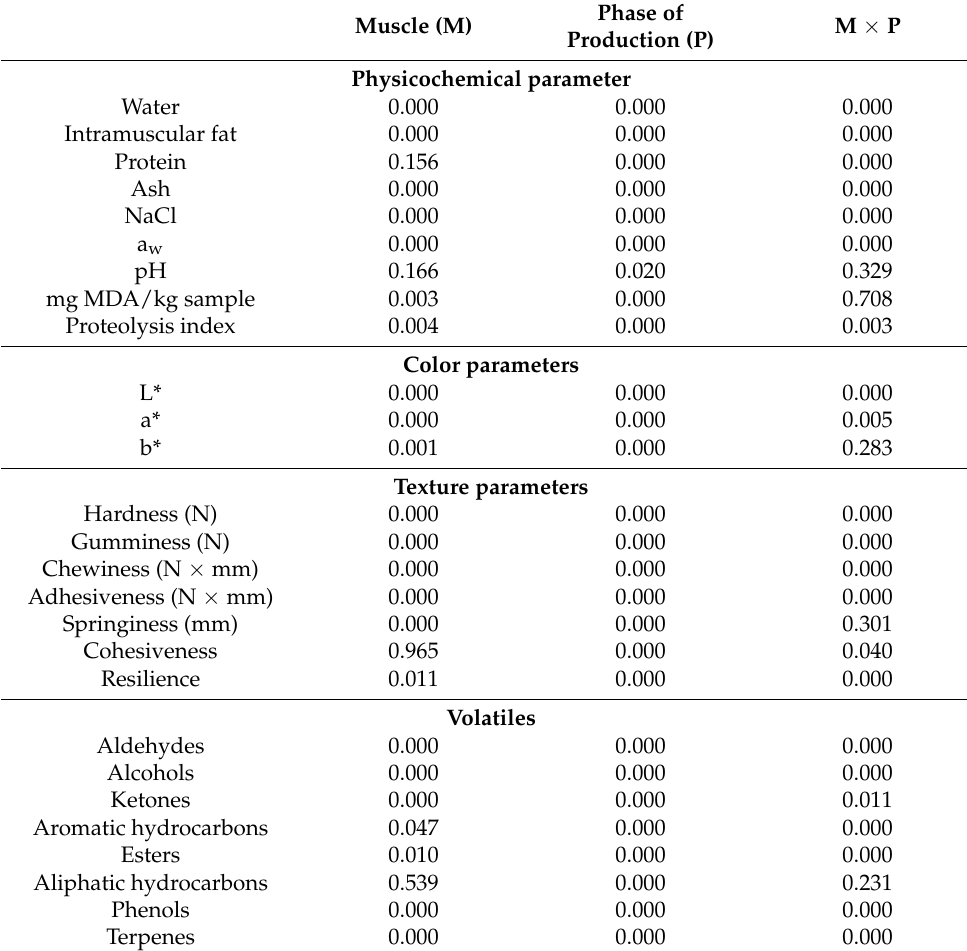
Table 4. p -value for each physicochemical parameter as obtained by GLM analysis.